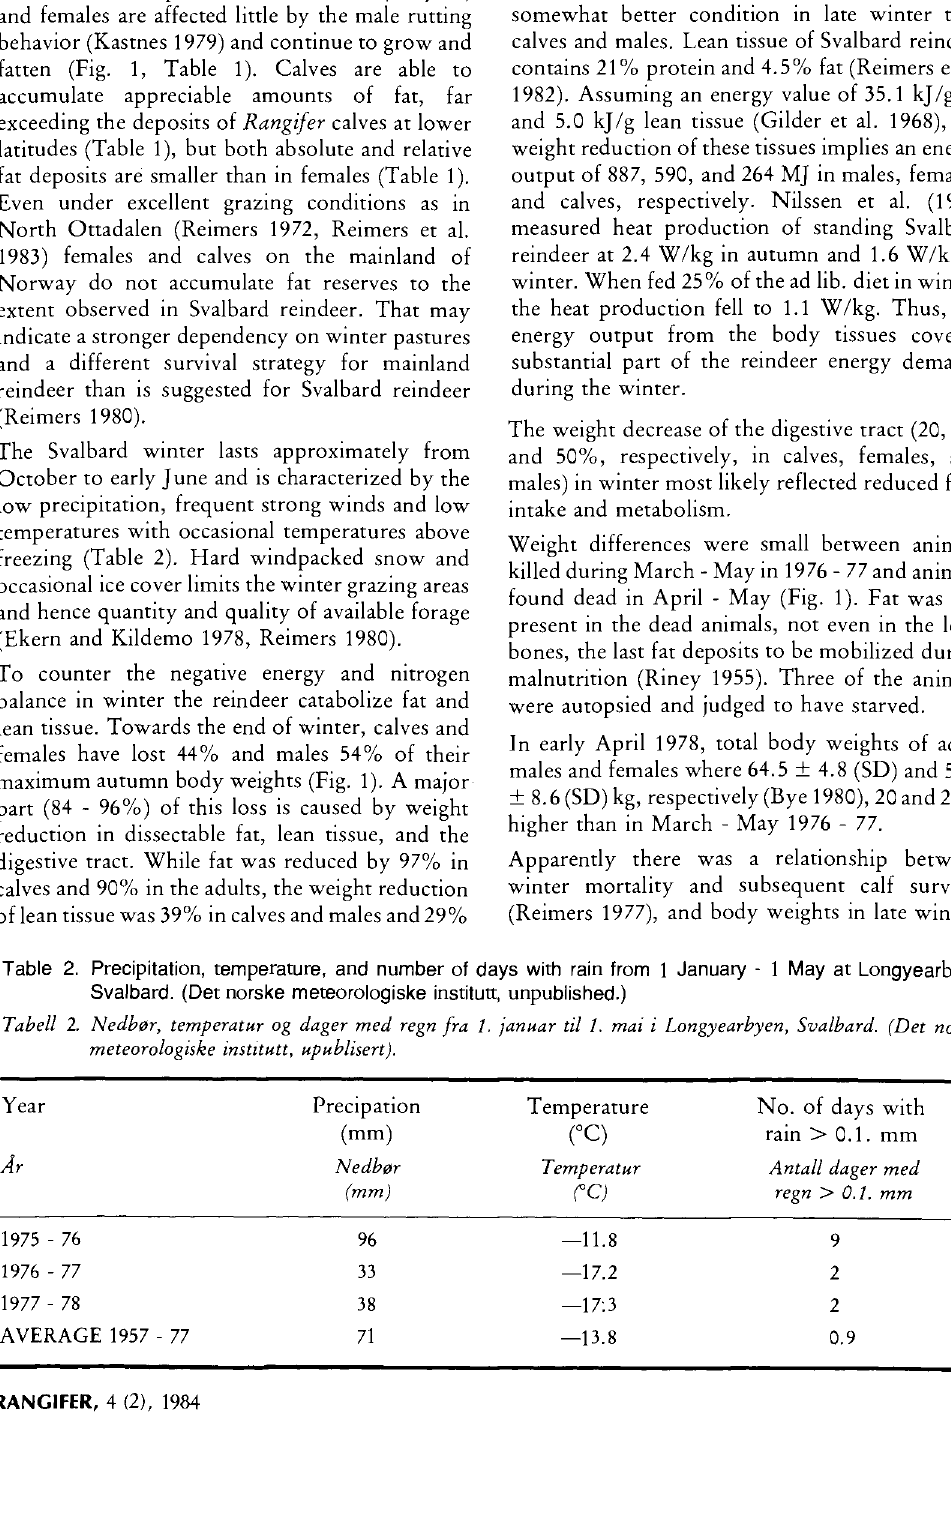
Table 2. Precipitation, temperature, and number of days with rain from 1 January - 1 May at Longyearbyen, Svalbard. (Det norske meteorologiske institutt, unpublished.) Tabell 2.